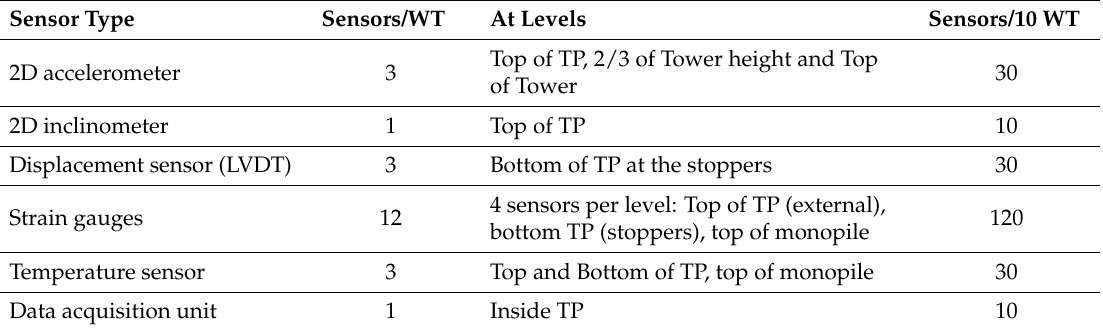
Table 6. SHM strategy: number, type and hardware